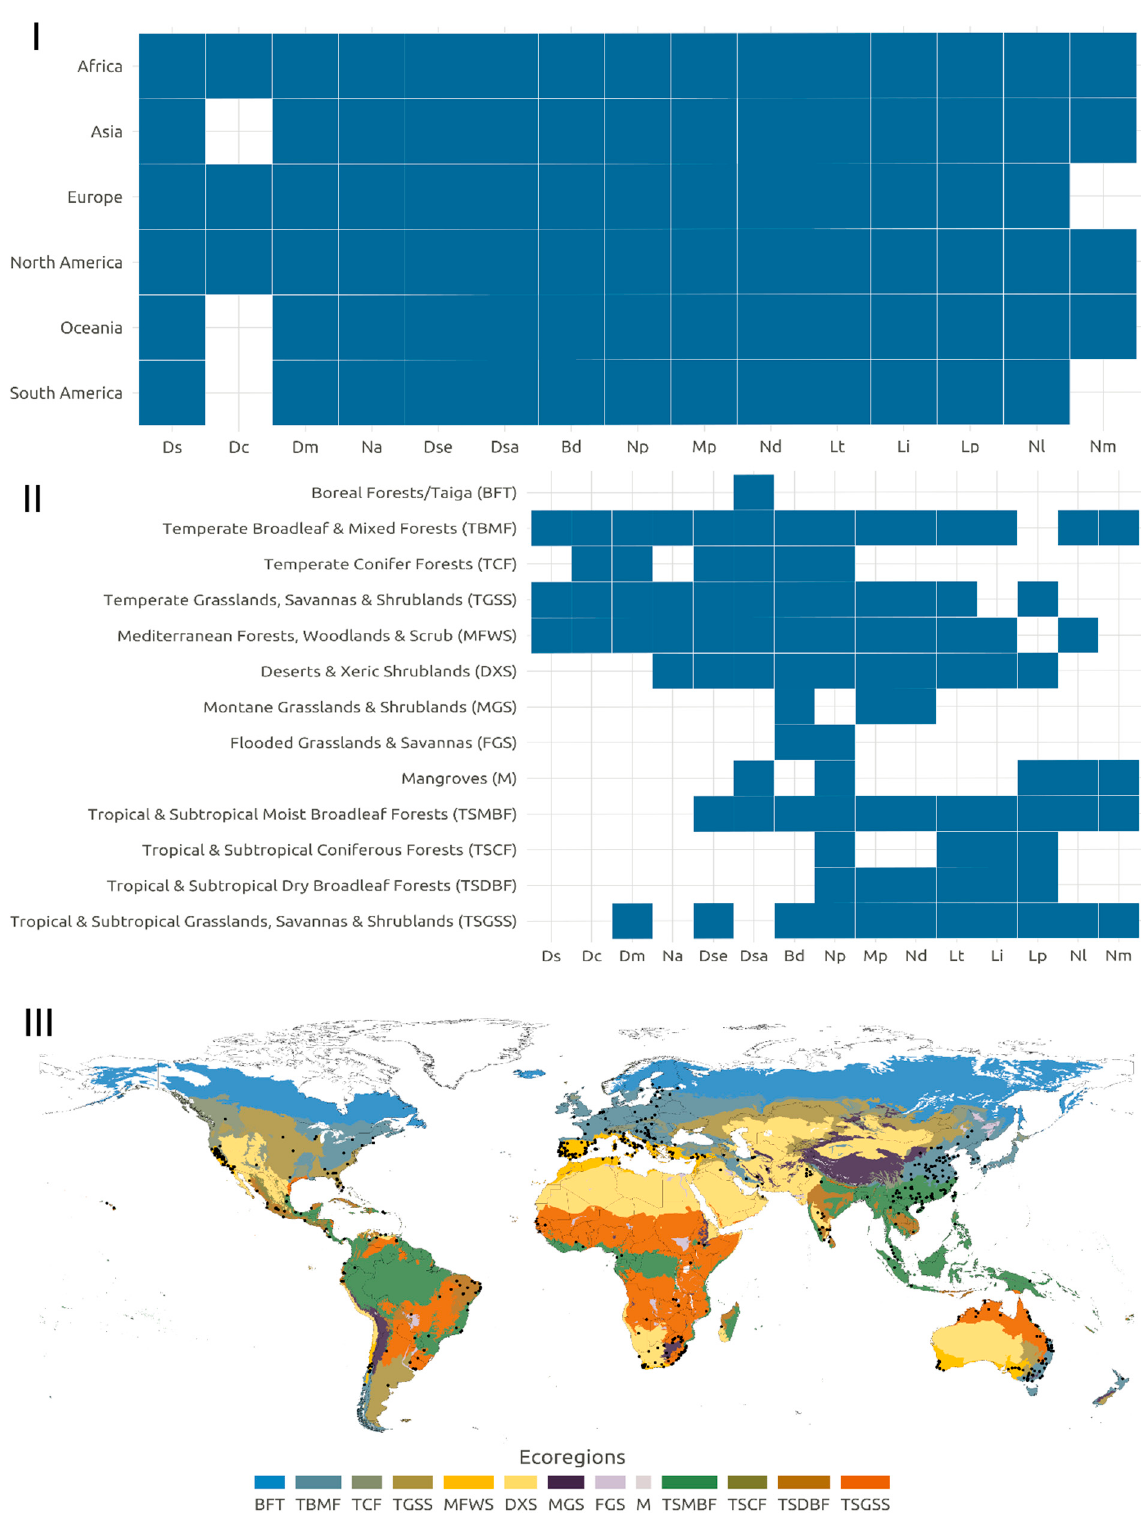
Figure 3. Worldwide occurrence of the main Botryosphaeriaceae species ( B. dothidea (Bd), D. corticola (Dc), D. mutila (Dm), D. sapinea (Dsa), D. seriata (Dse), Do. sarmentorum (Ds), L. iranensis (Li), L. pseudotheobromae (Lp), L. theobromae (Lt), M. phaseolina (Mp), N. australe (Na), Ne. dimidiatum (Nd), N. luteum (Nl), N. mangiferae (Nm), N. parvum (Np)). Data on continental occurrence were obtained from the literature. Points represent isolates with valid geographical coordinates from the literature and GenBank. A total of 786 geographical references were used.